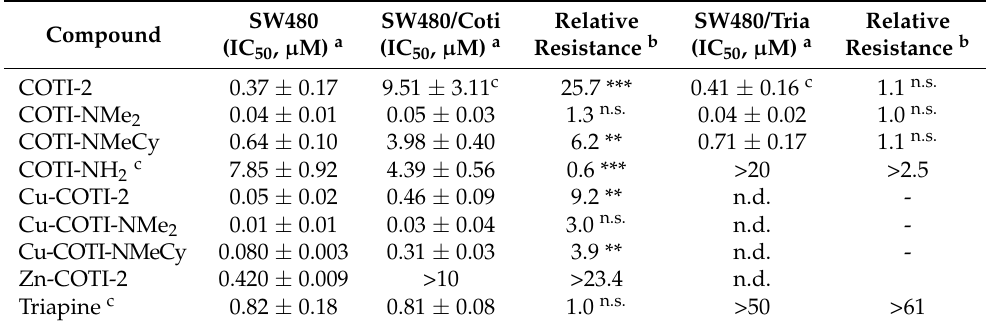
Table 4. Anticancer activity (IC 50 values after 72 h) of the indicated TSCs in SW480 cells, as well as the TSC-resistant SW480/Coti and SW480/Tria